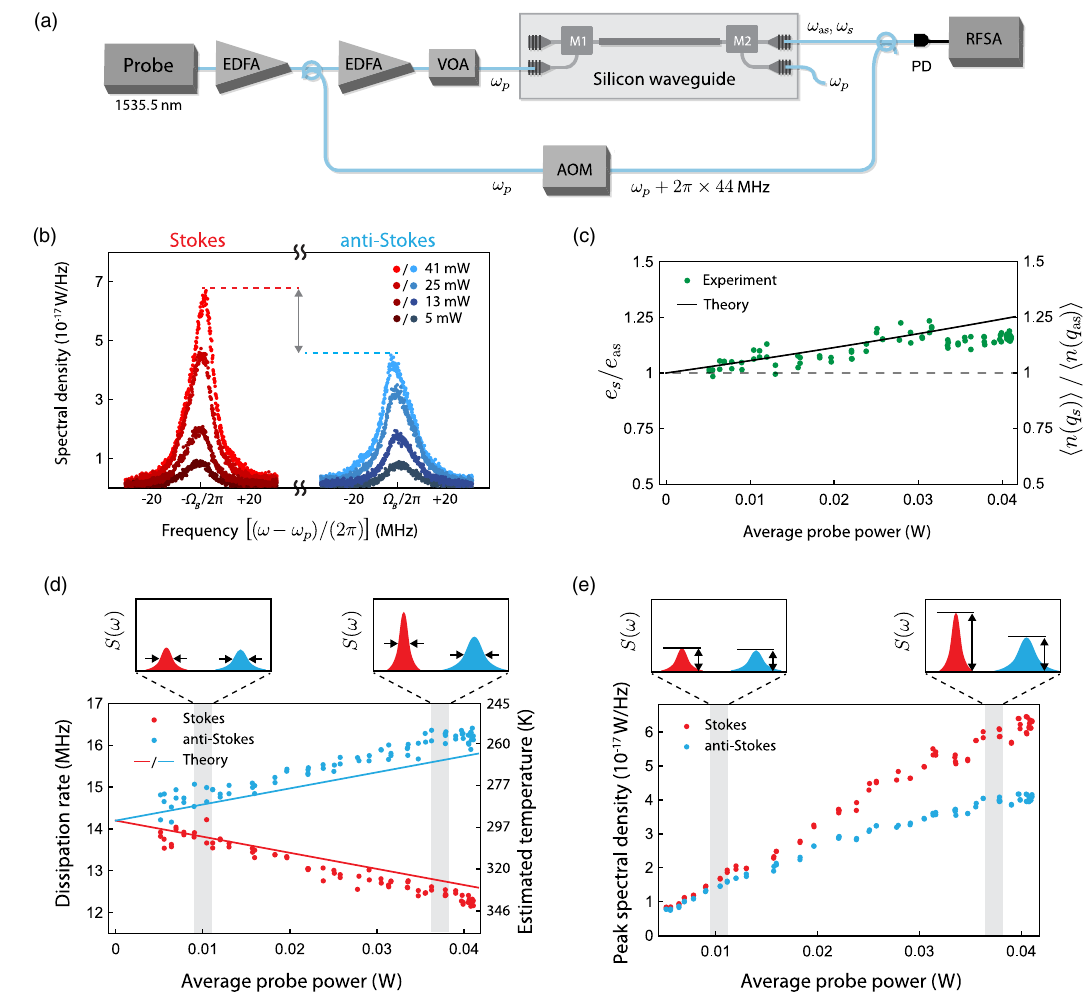
FIG. 2. Experimental heterodyne setup and measurements of spontaneous intermodal Brillouin scattering. Panel (a) diagrams the heterodyne scheme used to modify and probe the phonon dynamics. Experiments are performed at room temperature and atmospheric pressure. A cw laser source (vacuum wavelength of 1535.5 nm) is used to synthesize a strong probe wave (upper arm) and a 44-MHz blueshifted optical local oscillator for heterodyne detection (lower arm). The probe wave intensity is controlled using an EDFA and a VOA before being coupled on chip, where it interacts with a thermal phonon field via intermodal Brillouin scattering. The scattered light propagates in the antisymmetric spatial mode, and then it is combined with the optical LO. The interference of the Stokes and anti- Stokes waves with the optical LO on a photoreceiver produces unique microwave spectra centered at Ω Ω − 2 π × 44 MHz, respectively. Panel (b) plots a series of Stokes and anti-Stokes heterodyne spectra at four distinct probe powers. B Note the power-dependent asymmetry between the Stokes and anti-Stokes spectra in both the peak spectral density and spectral width. (c) shows the relative scattering efficiencies of the Stokes and anti-Stokes processes (and respective phonon occupations) as the probe power is increased. Panel (d) plots the fitted linewidths of the Stokes and anti-Stokes spectra. The temperature is estimated using the model derived in Appendix A. These measurements reveal that the collective lifetime of the anti-Stokes phonons is reduced, while that of the Stokes phonons is enhanced. At a maximum probe power of 42 mW, this asymmetry in spectral width corresponds to more than 30 K of cooling or heating from room temperature. (e) plots the peak spectral density of these spectra as a function of probe power. The overall decrease in scattering efficiencies can be attributed to the power-dependent transmission of the integrated mode multiplexer (M2). As a first-order benchmark, the observed scattering efficiencies for the Stokes and anti-Stokes process are approximately 3 . 3 × 10 − 8 , in agreement with the predicted value ( 3 . 15 × 10 − 8 ) for spontaneous forward Brillouin scattering the light through an acousto-optic frequency shifter, which